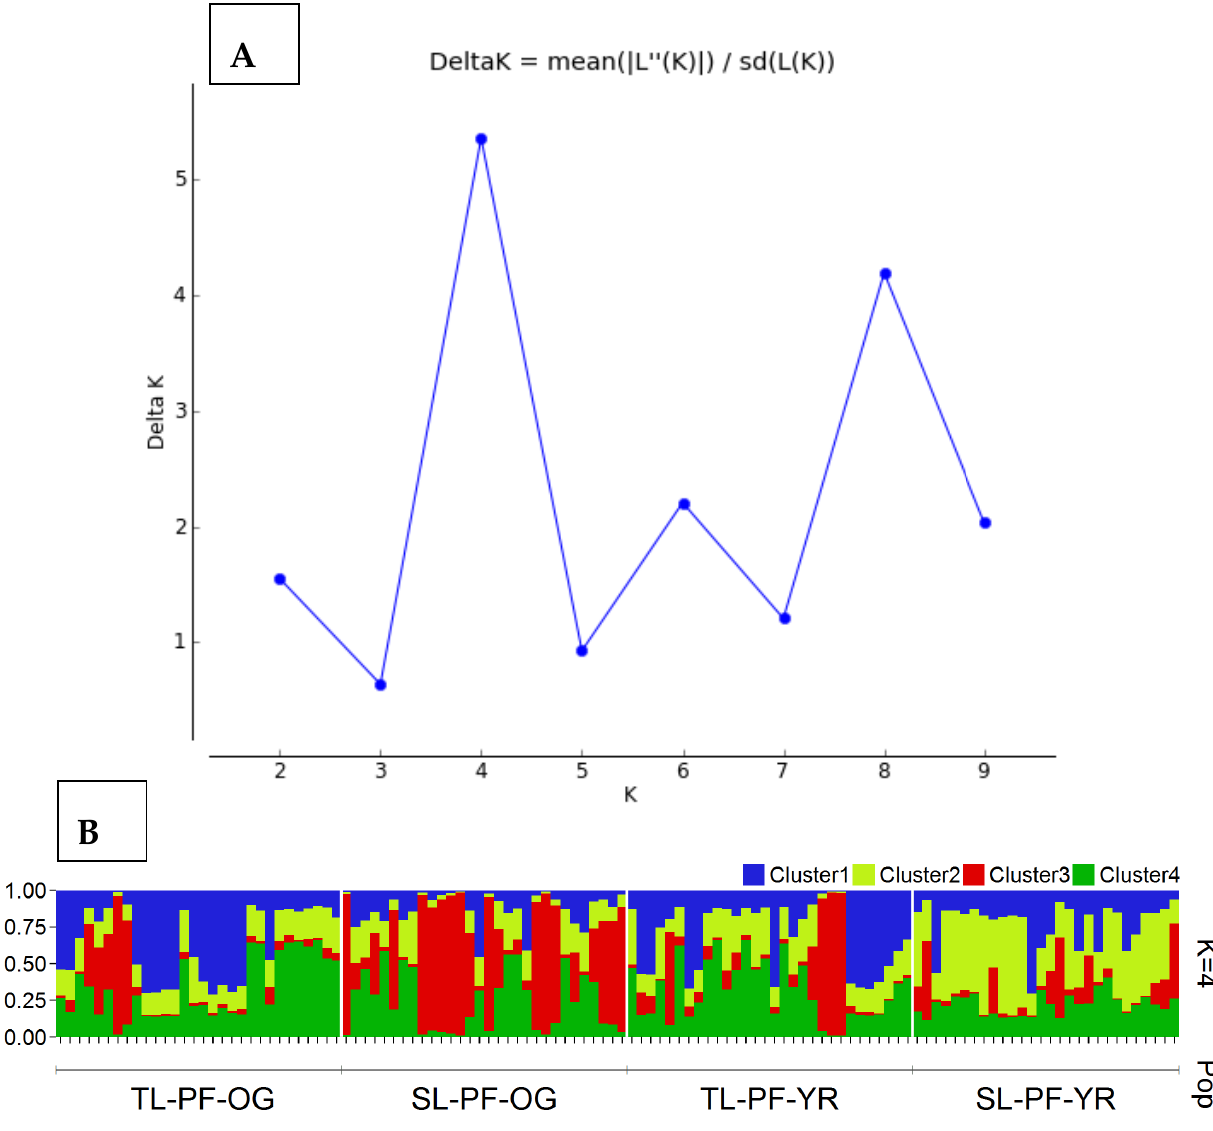
Figure 5. ( A ). A summary scatterplot of DeltaK values for white spruce populations testing K = 2–8 clusters, calculated from the STRUCTURE results using the Evanno et al. [54] method. ( B ). Summary bar plot of estimated membership coefficient (Q) of the studied white spruce individuals from the four populations from the STRUCTURE analysis for K = 4. Each individual is represented by a single vertical line while each color represents one cluster/genetic group. TL-PF-OG, Tibiska Lake post-fire natural old-growth; SL-PG-OG, Sanctuary Lake post-fire natural old-growth; TL-PF-YR, Tibiska Lake post-fire natural young regeneration; SL-PF-YR, Sanctuary Lake post-fire natural young regeneration.